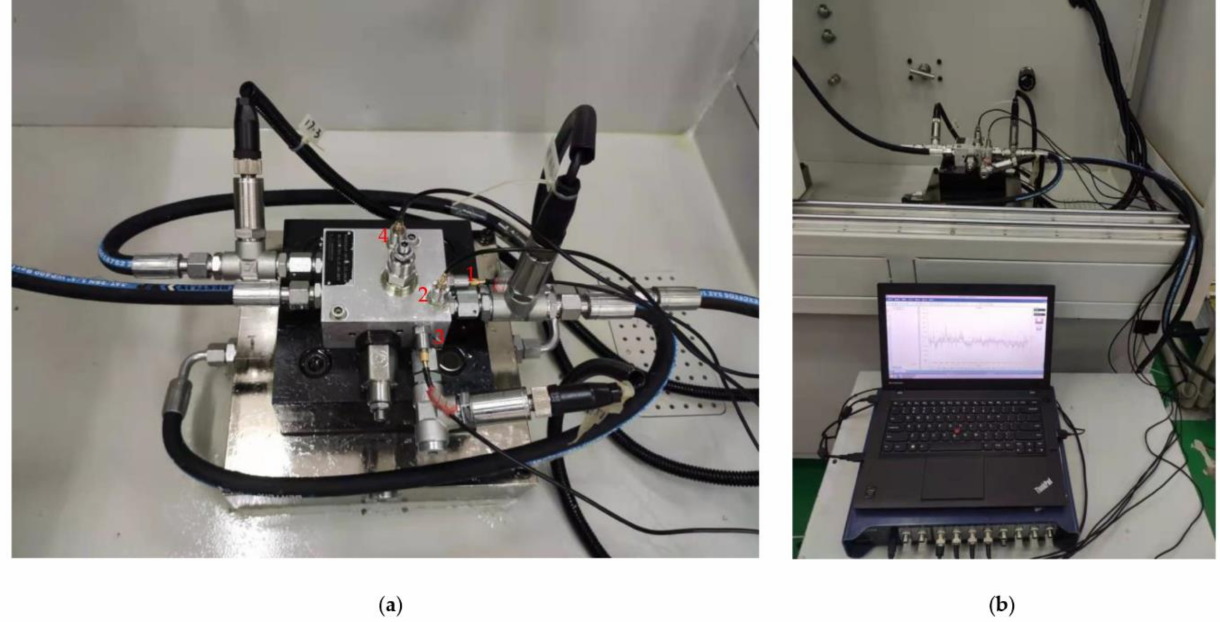
Figure 8. Waterproof valve failure test bench: ( a ) tested valve part; ( b ) vibration signal acquisition.